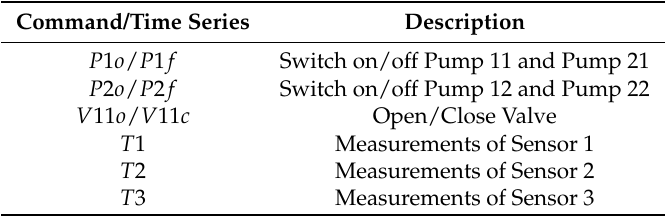
Figure 6. Structure of tank system. Adapted with permission from [15], Copyright Elsevier, 2016. Table 1. Description of data.